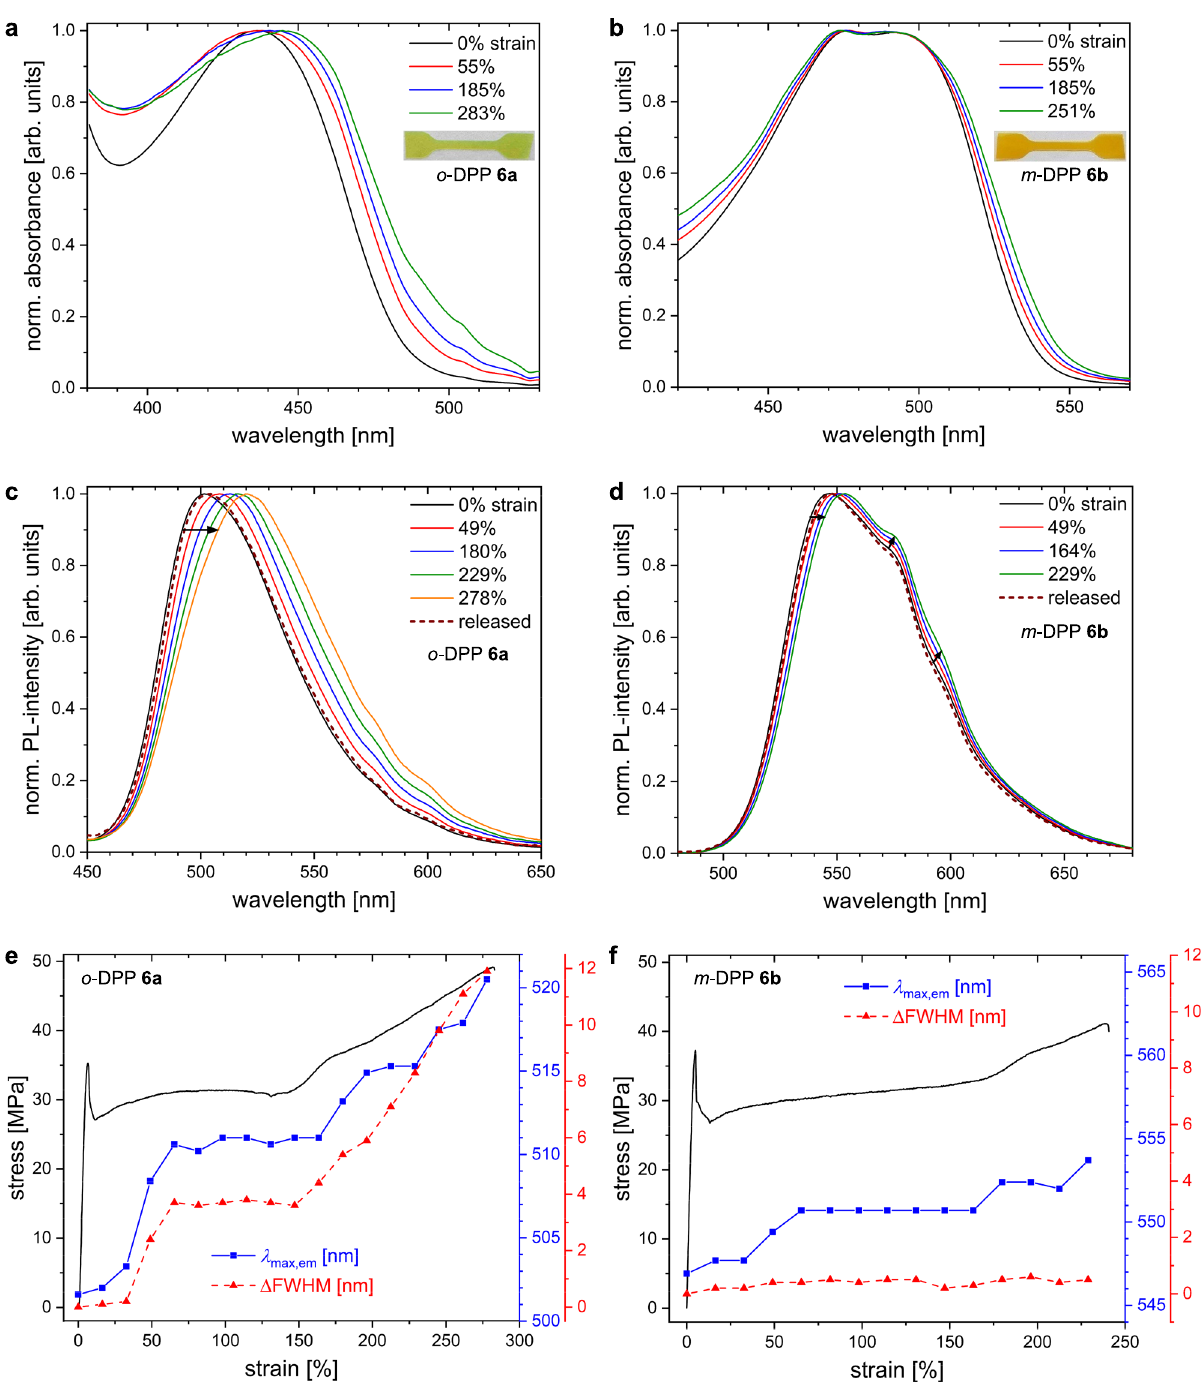
Fig. 5 Combination of tensile testing and in-situ optical characterization of thin fi lms. Left column: o -DPP 6a ; right column: m -DPP 6b . a , b UV-vis absorption spectra measured during/after stress-strain experiments and ( c , d ) the corresponding emission spectra. e , f Stress-strain curves (black) together with the detected emission maxima λ max,em (blue) and the changes in Full Width at Half Maximum of the emission bands ( Δ FWHM, red). Strain values as percentage elongation with respect to initial specimen